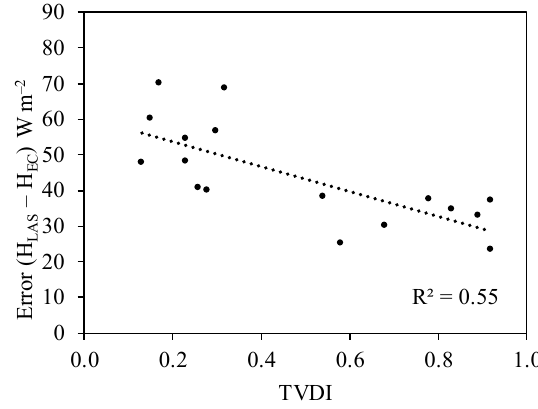
Figure 10. Comparison between the error in H (H LAS − H EC ) and temperature vegetation dryness index (TVDI).